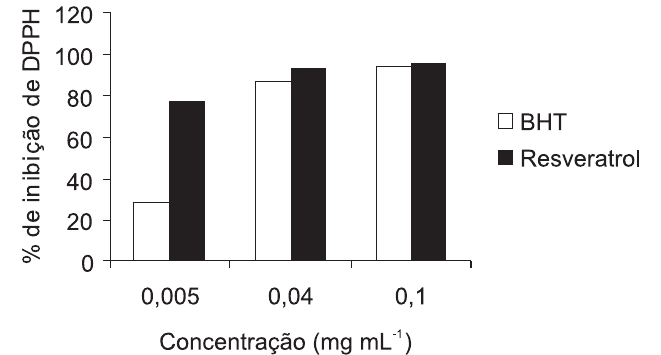
FIGURA 6 - Percentual de inibição de DPPH do BHT e do resveratrol (n=3). Amostras de BHT e resveratrol preparadas conforme descrito na metodologia.